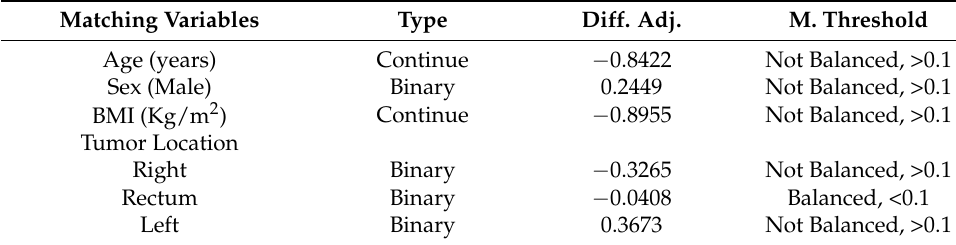
Table 2. Balance measures of propensity score